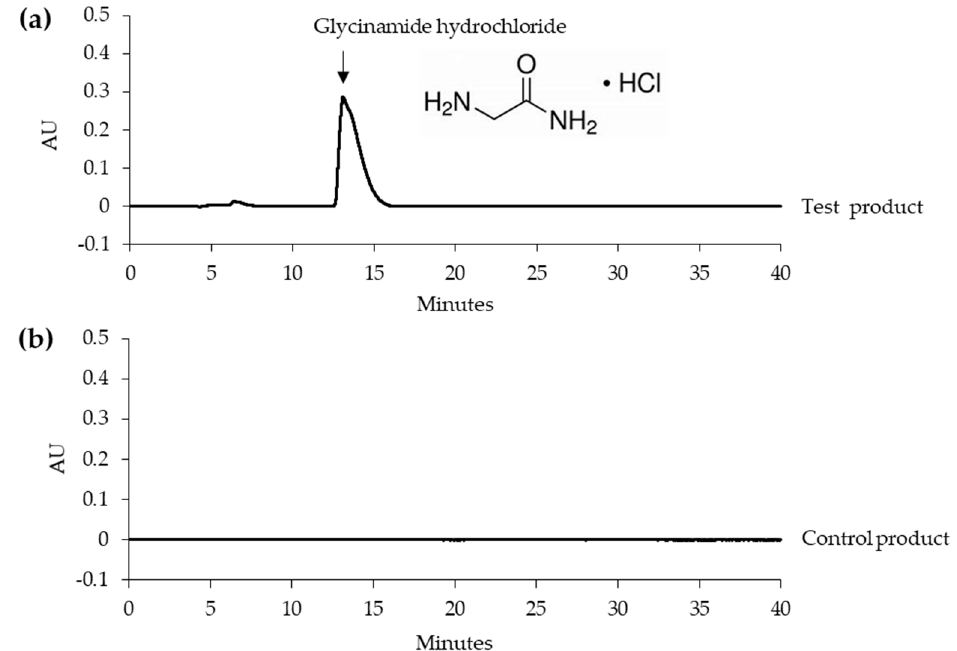
Figure 1. Typical HPLC chromatograms of the test and control products. ( a ) Test product. ( b ) Control product. The glycinamide hydrochloride peak is indicated by an arrow. The chemical structure of glycinamide hydrochloride is also shown.